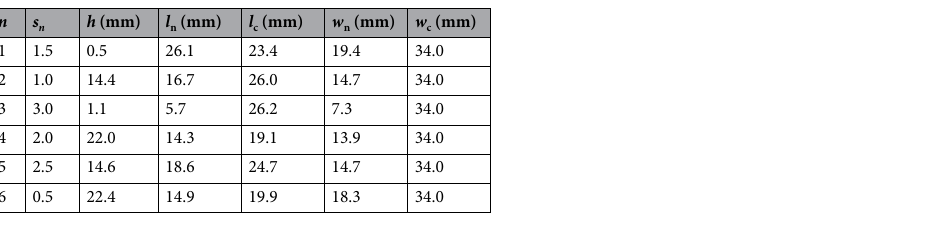
Table 2. Geometrical parameters of the